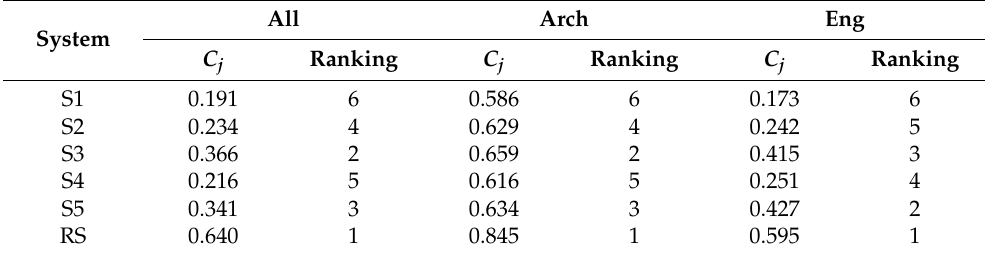
Table 11. The resultant efficiencies and ranks by